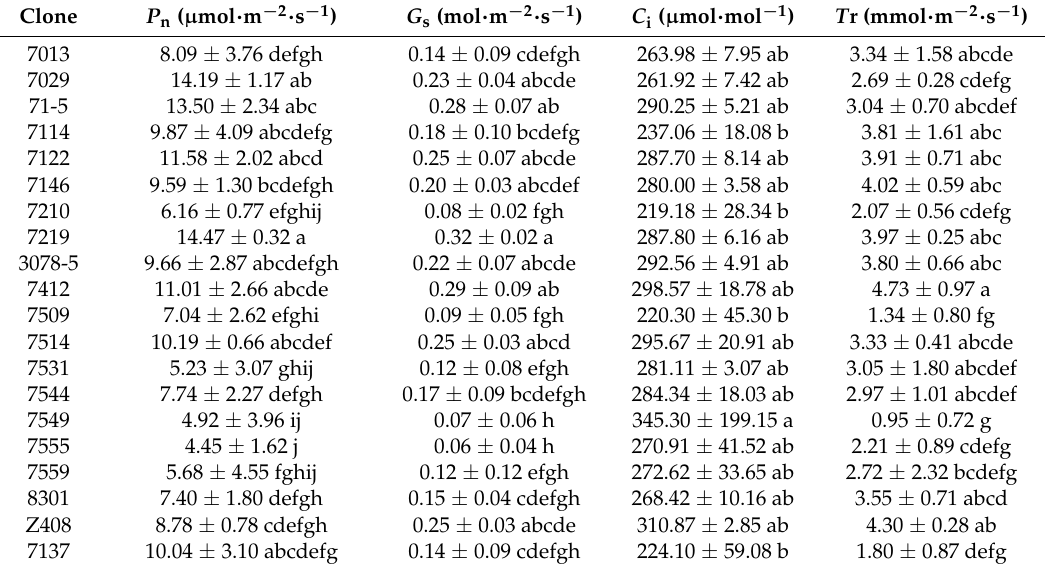
Table 3. Values of gas exchange parameters among teak clones from different